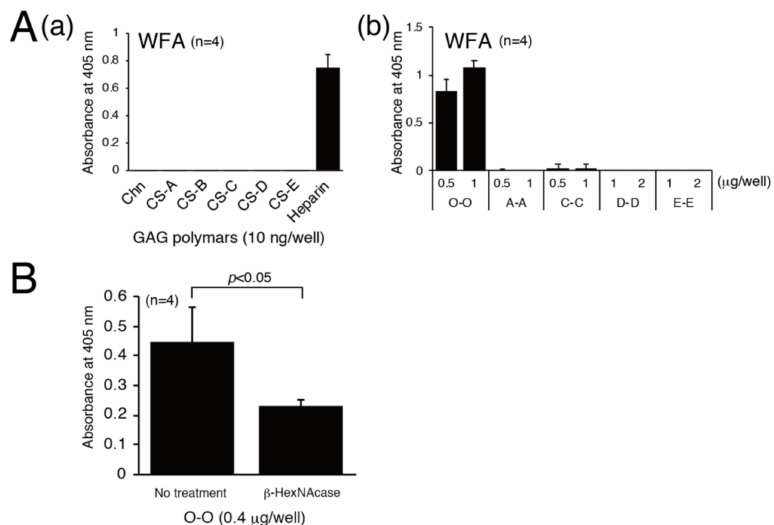
Figure 2. WFA specifically recognize non-sulfated tetrasaccharides ( A ), Biotinylated Chn and GAG polymers (CS-A, CS-B, CS-C, CS-D, and heparin) ( a ) and chemically synthesized biotinylated tetrasaccharides (O-O, A-A, C-C, D-D, and E-E) ( b ) were immobilized onto a streptavidin-coated plate, then horseradish-conjugated WFA was added to each well. WFA binding to immobilized GAGs or tetrasaccharides was measured by ELISA. ( B ) WFA binding to O-O tetrasaccharides digested with or without β -HexNAcase was